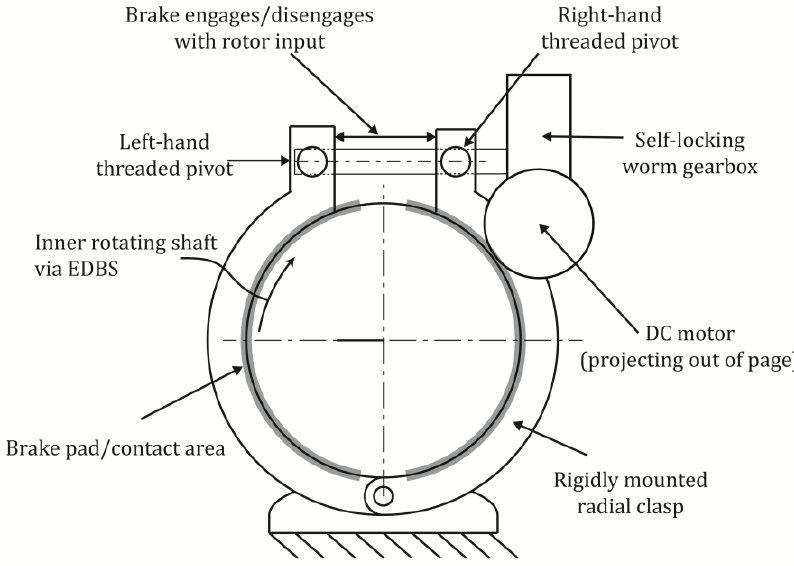
Figure 14. 2D representation of the inline threaded clamp arrangement.